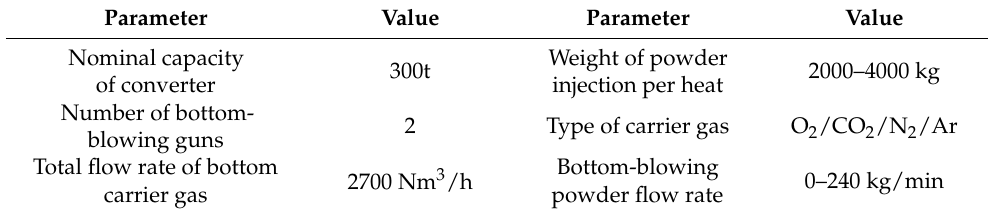
Figure 1. Schematic diagram of converter bottom-blowing O 2 -CaO process. Table 1. Parameters of bottom-blowing O 2 -CaO process in 300 t dephosphorization converter.